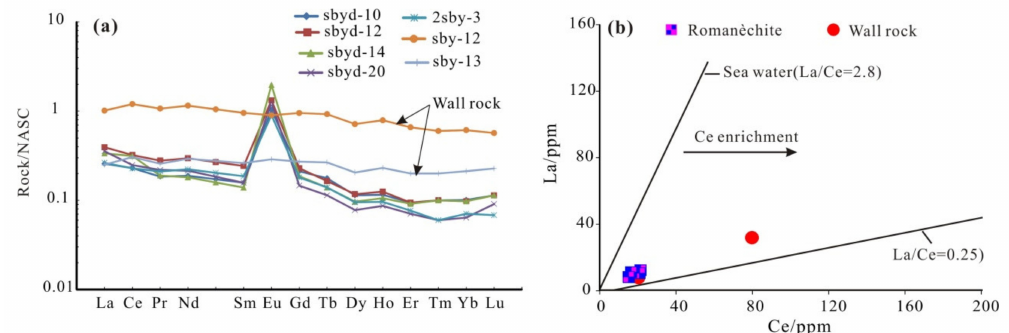
Figure 14. REE content of the Sanbao Mn–Ag ore and wall rocks (normalized to the NASC (North American shale composite) values given by [54]): ( a ) REE distribution curves; ( b ) correlation between La and